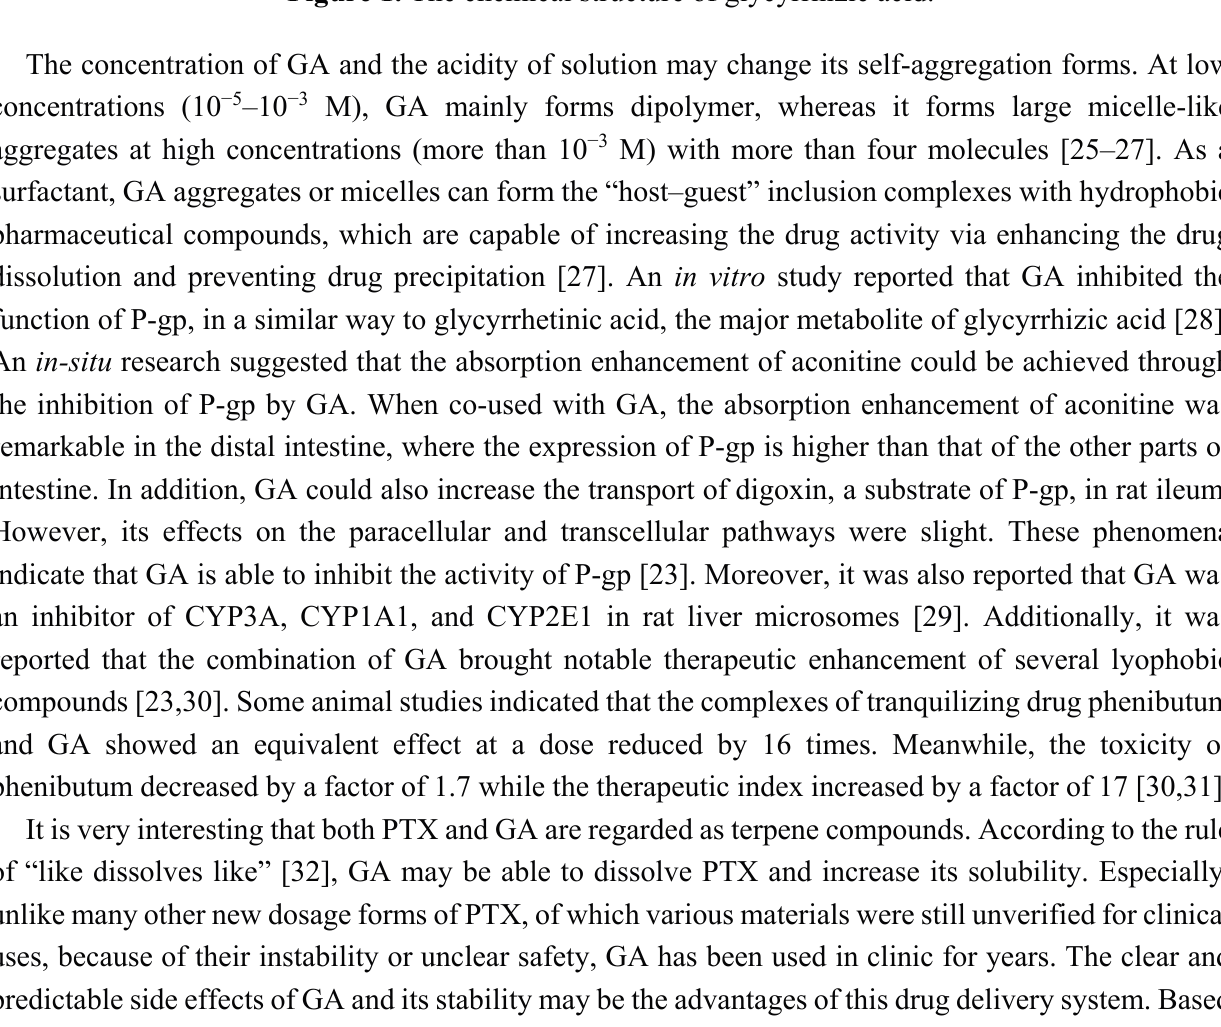
Figure 1. The chemical structure of glycyrrhizic